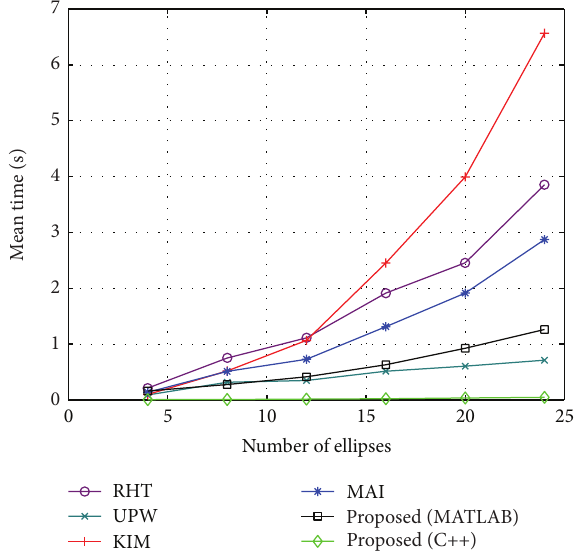
Figure15:Timerequirementofeachmethodtoprocessimageswith different number of